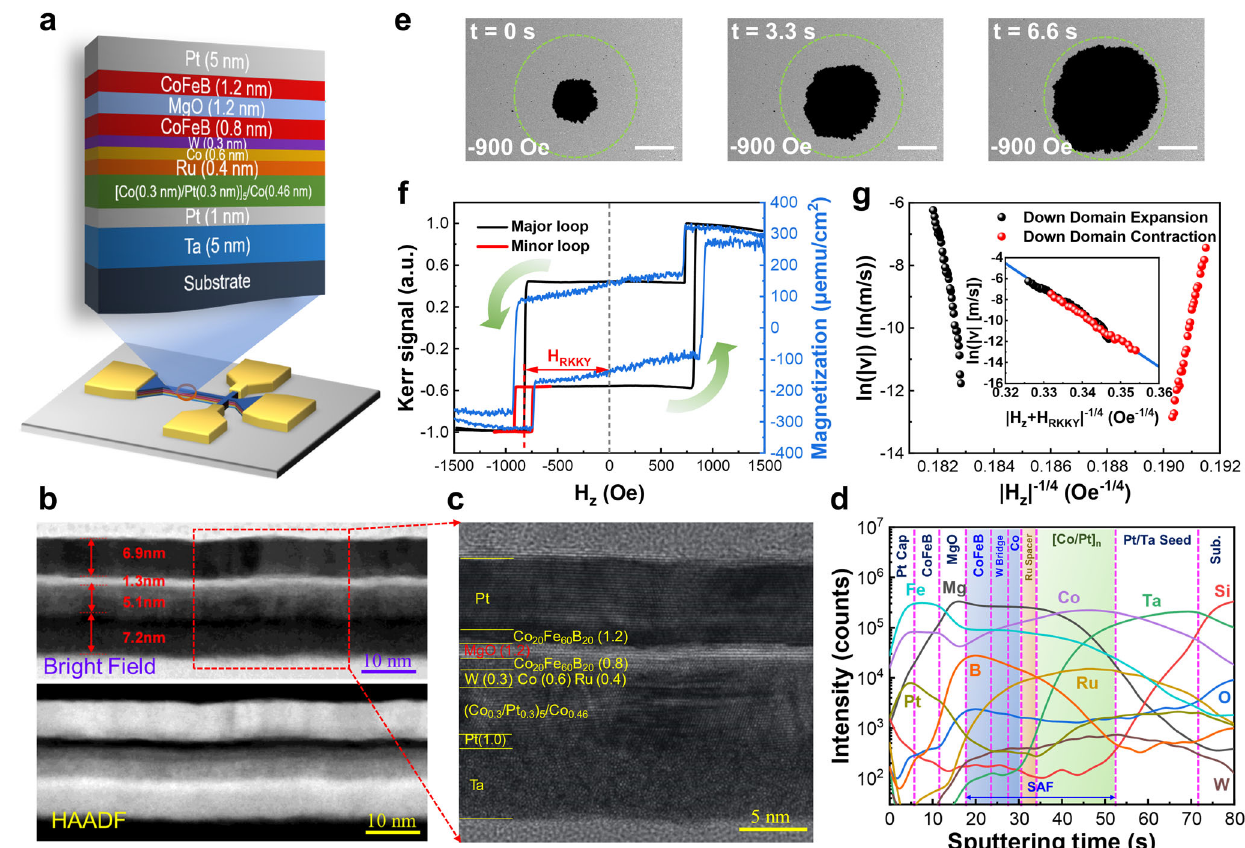
Fig.1|DomainwallmotiondynamicsinSAFstructure.a Schematicof fi lmsstack and patterned device. Corresponding STEM and HAADF b , HRTEM c images and atomic level composition depth pro fi le using SIMS analysis d . e Kerr images recorded at different time under an OOP magnetic fi eld of 900Oe. The black and gray region refers to down and up domain, respectively. DW con fi guration is